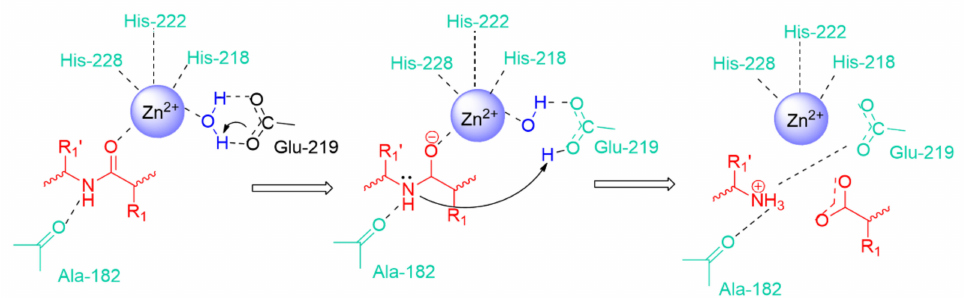
Figure 2. General representation of amide bond hydrolysis in the catalytic site of MMPs.